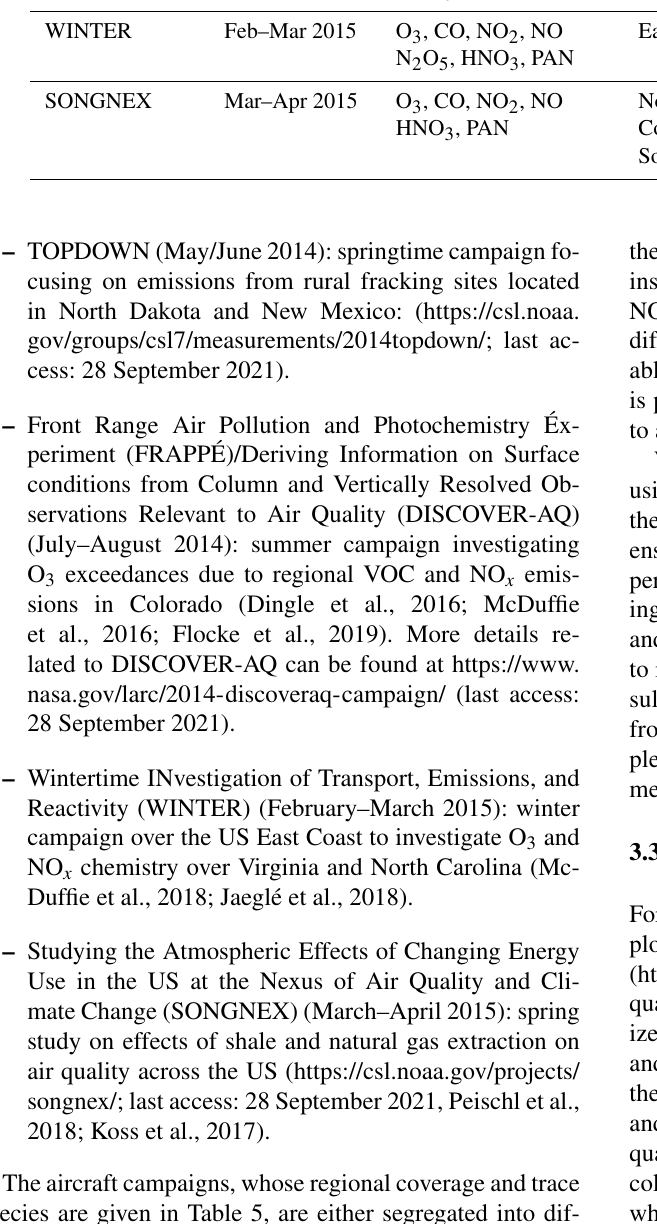
Table 5. Details of the various aircraft measurement campaigns in 2014/2015 used in this study. Campaign Date Trace species US state Regional domain (Lat, Long) TOPDOWN